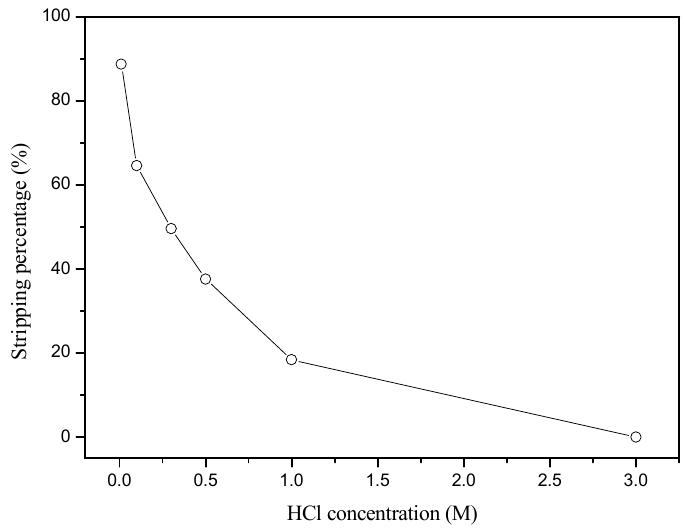
Figure 5. E ff ect of HCl concentration on the stripping of Ru(III) from the loaded Aliquat 336. Figure 5. Effect of HCl concentration on the stripping of Ru(III) from the loaded Aliquat 336. When HCl concentration is too low, there might be some change in the predominant species of Ru(III). Therefore, 0.1 M HCl was selected as an optimum stripping solution and a McCabe-Thiele stripping diagram was constructed. The volume ratio of aqueous to organic was varied from 10:1 to 1:3 and the corresponding McCabe-Thiele diagram is shown in Figure 6. Three stages of Figure 5. Effect of HCl concentration on the stripping of Ru(III) from the loaded Aliquat 336.